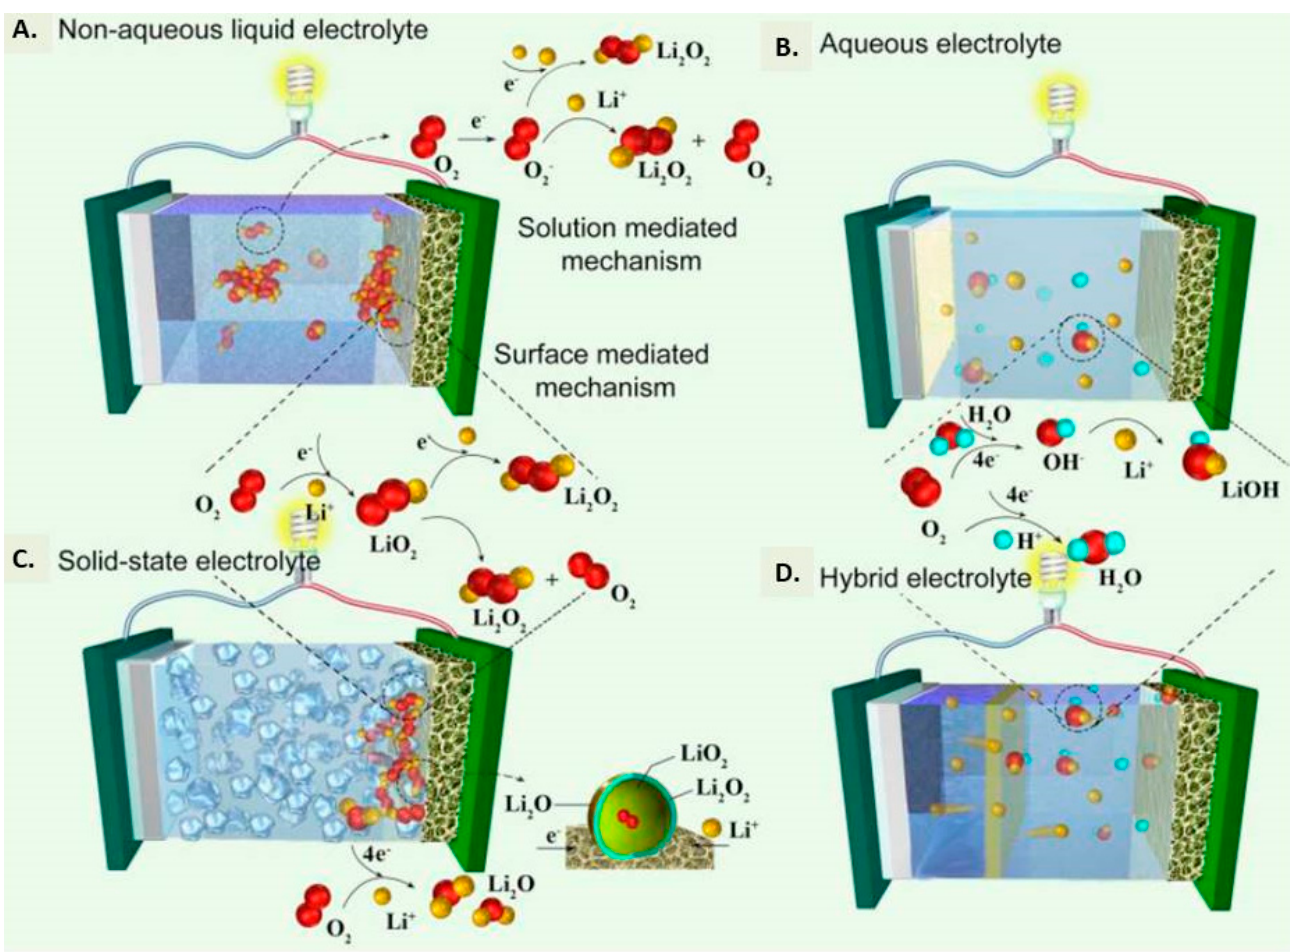
Figure 4. Li-Air batteries of different electrolytes and their mechanisms. ( A ) Non-aqueous liquid electrolyte, ( B ) Aqueous electrolyte, ( C ) Solid-state electrolyte, ( D ) Hybrid electrolyte. Reprinted/adapted with permission from ref. [50]. Copyright 2020, copyright Wiley-VCH.